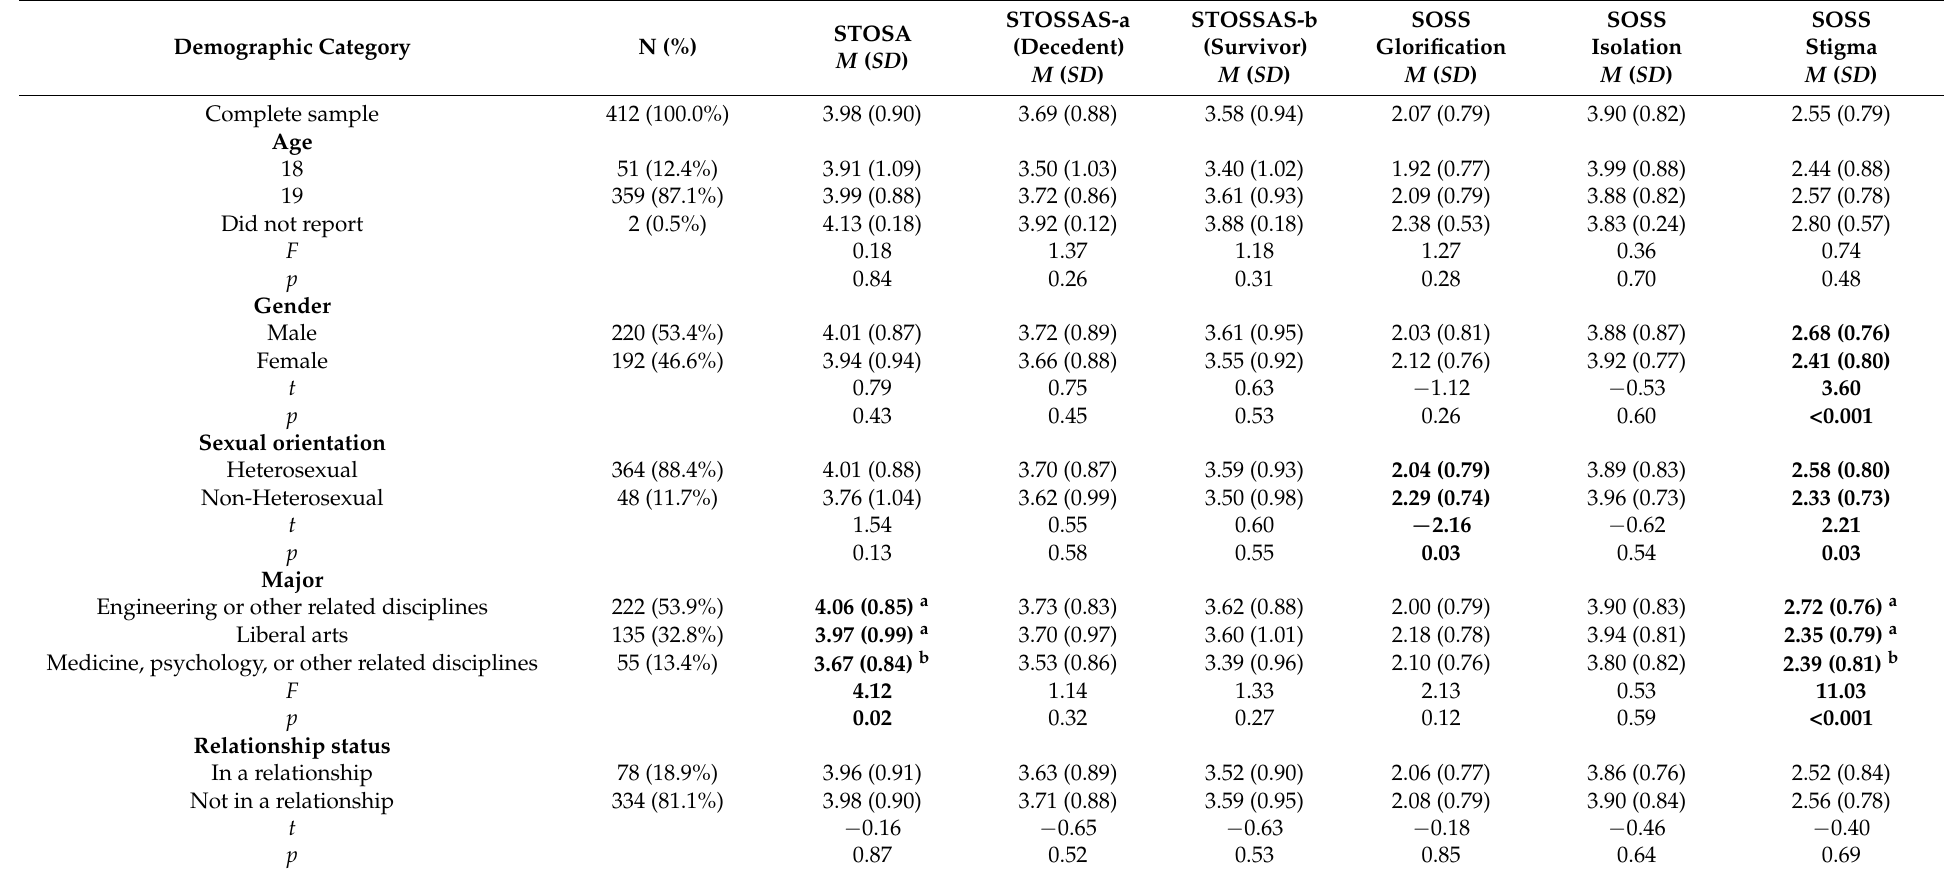
Table 1. Descriptive statistics for participants and relationship with Stigma of Suicide Attempt Scale (STOSA), Stigma of Suicide and Suicide Survivor Scale (STOSSAS), and Stigma of Suicide Scale (SOSS) scores (N =